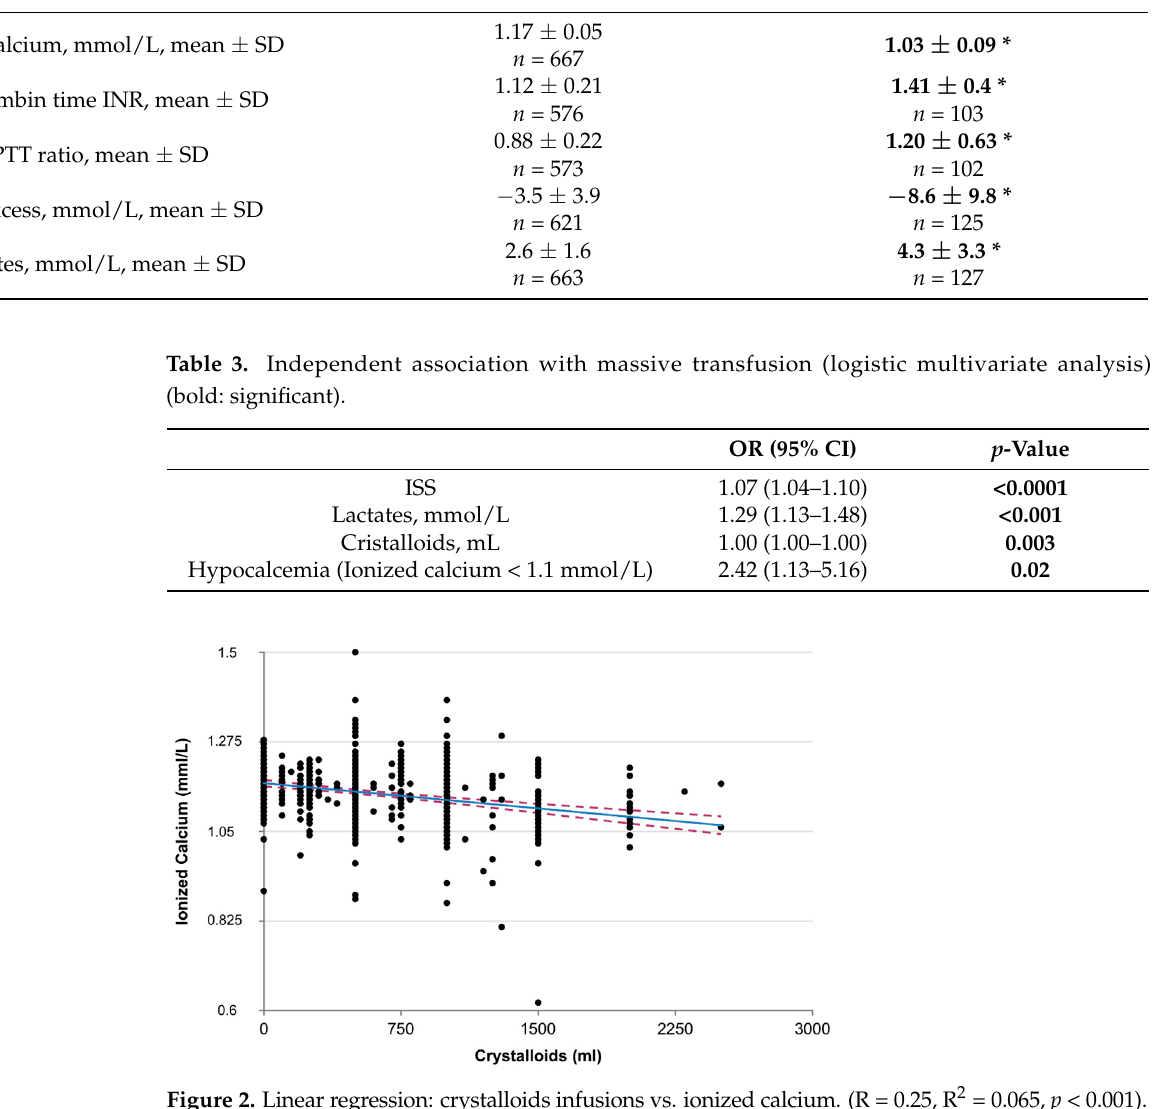
Table 3. Independent association with massive transfusion (logistic multivariate analysis) (bold: significant).